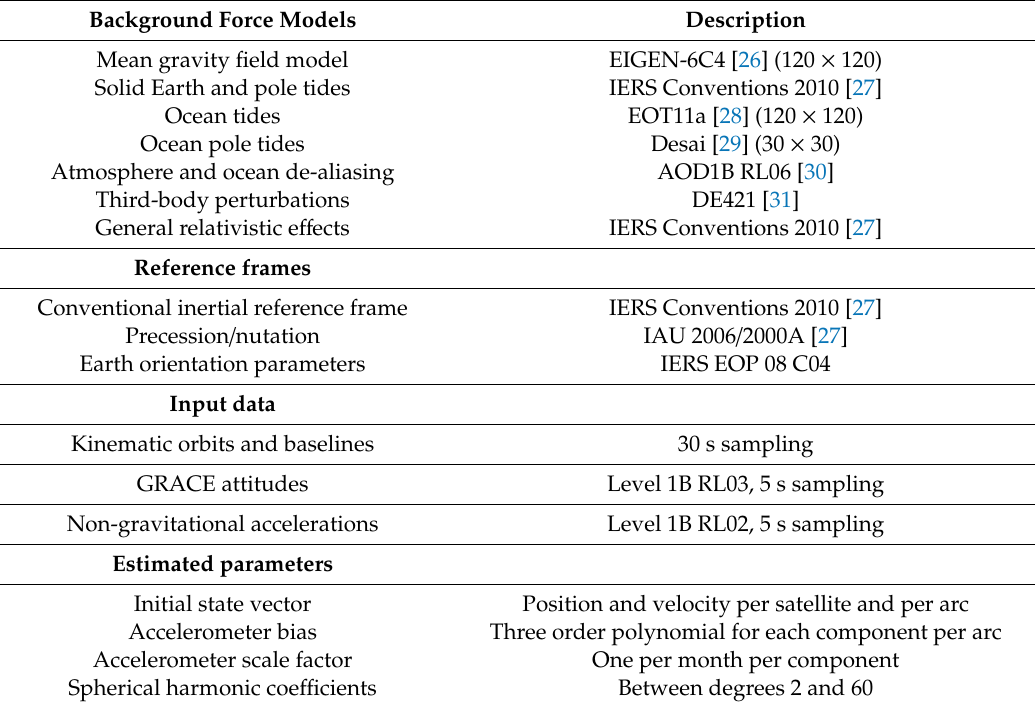
Table 1. Data and models used for gravity field